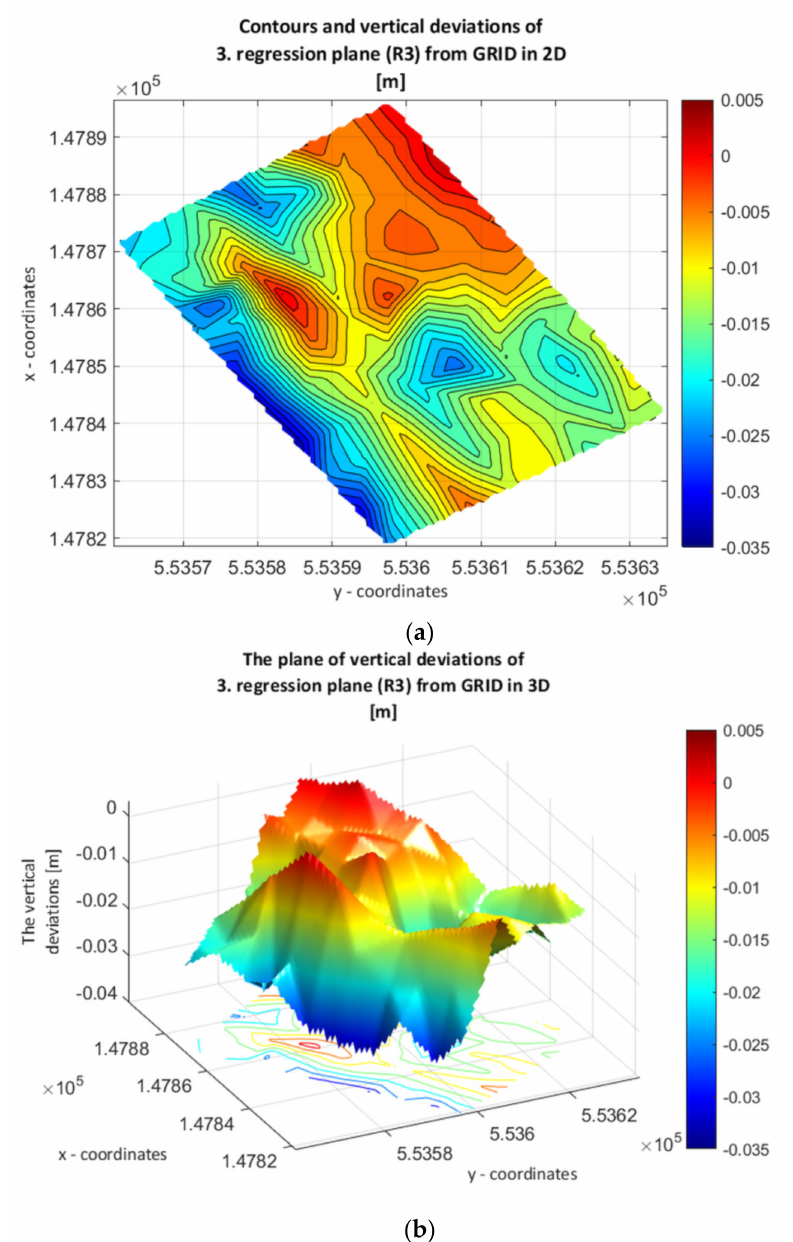
Figure 11. Display of areas of deformations on the runway based on the geodetic monitoring in 2D ( a ) and in 3D ( b